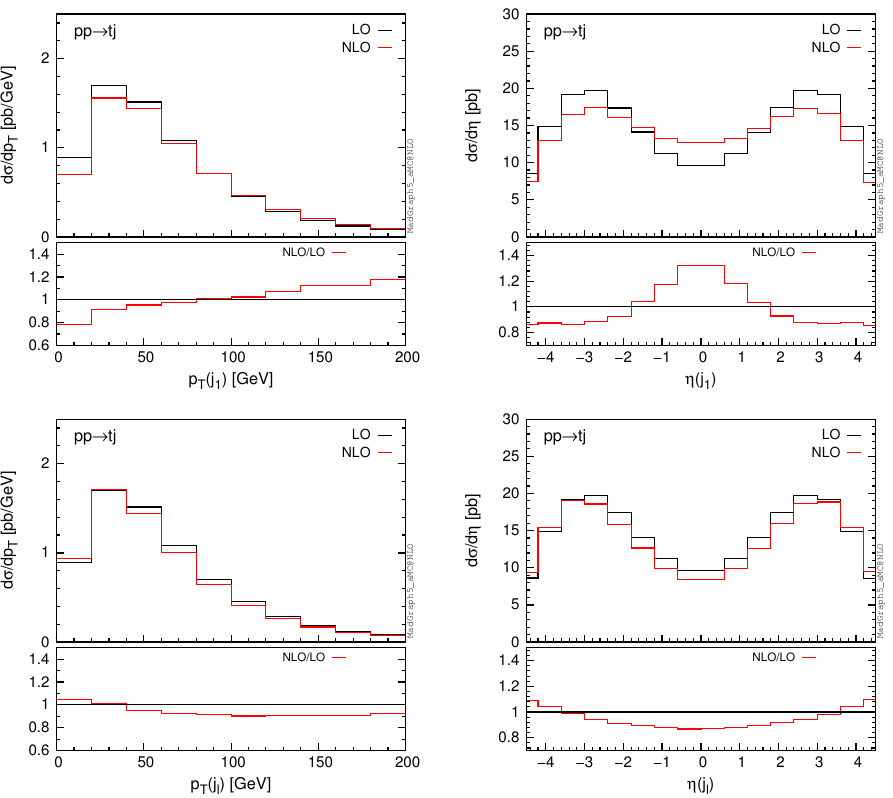
Figure 11 . Di(cid:11)erential distributions for the process pp ! tj l at LO and NLO QCD accuracy. They can be compared with (cid:12)gures 20 and 22 (bottom-left plots) of ref.